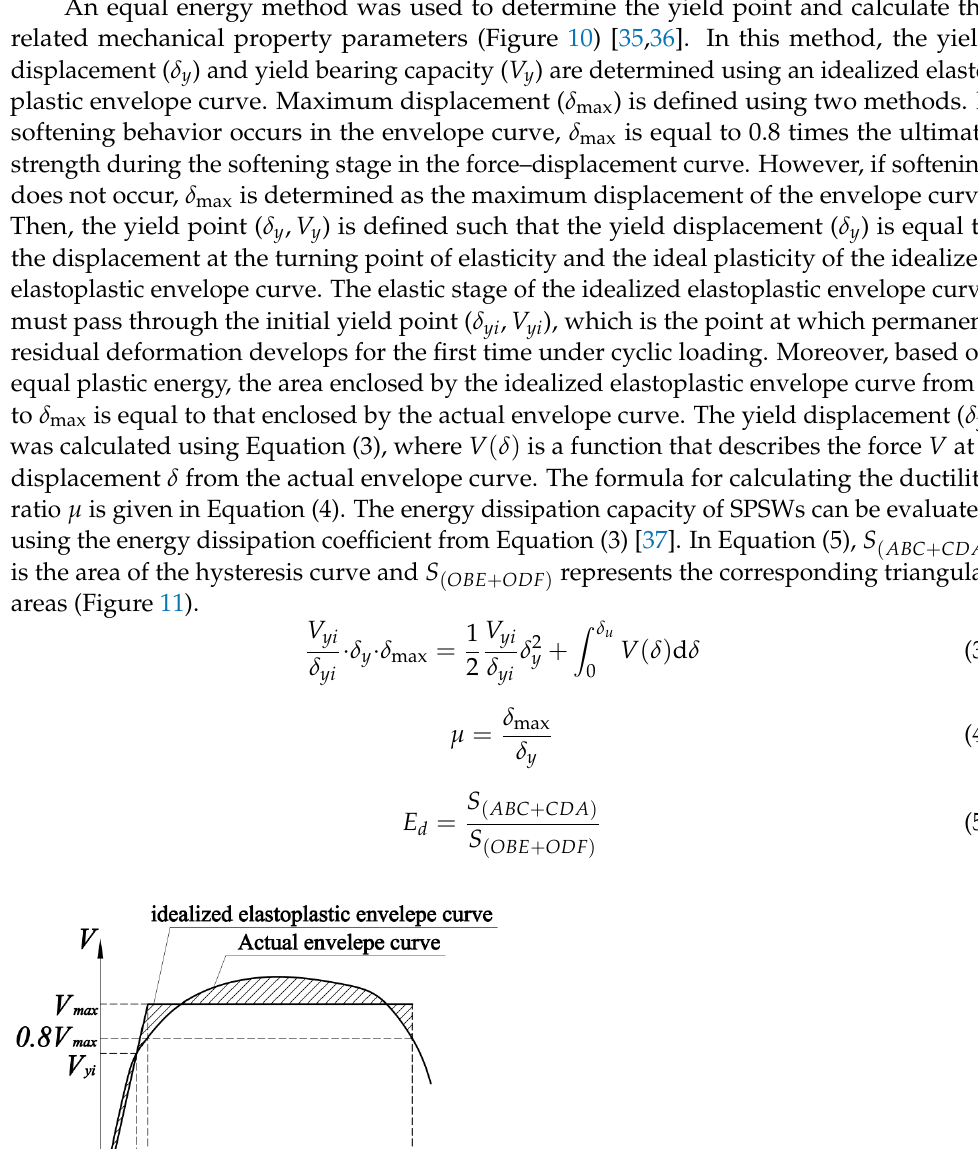
Figure 9. Partial models: ( a ) SPSW-N8; ( b ) SPSW-T; ( c ) FRAME.